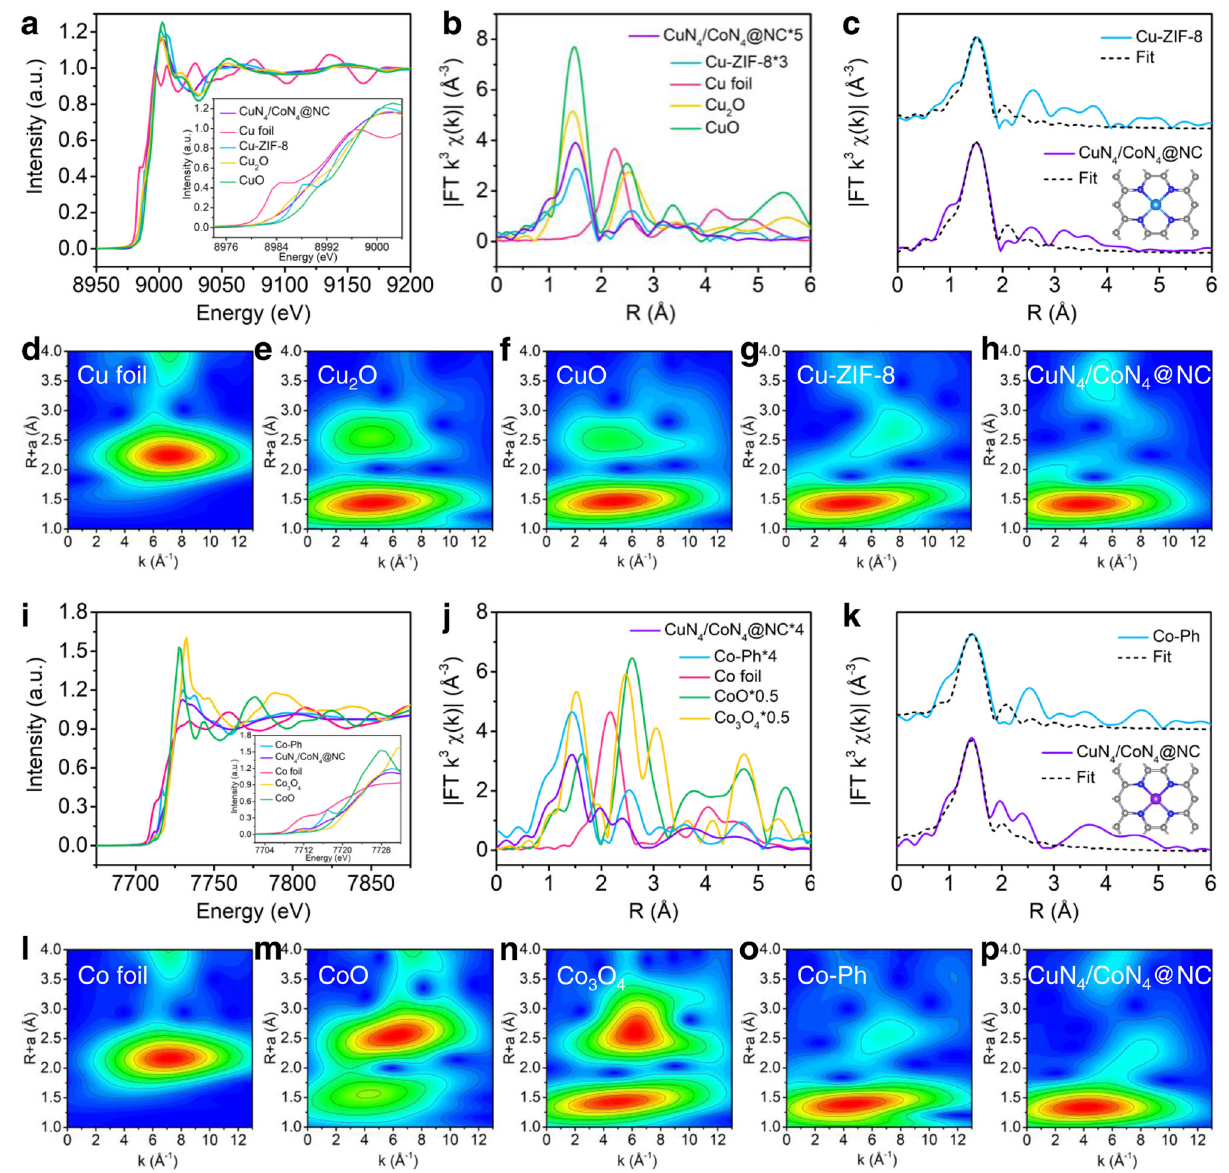
Fig. 2 | Atomic structural analysis of CuN 4 /CoN 4 @NC. a Cu K-edge XANES spectra, b Fourier-transformed (FT) k 3 -weighted EXAFS spectra for the Cu K-edge, c CuK-edgeEXAFS fi ttingcurvesofCuN 4 /CoN 4 @NCandCu-ZIF-8inRspace(inset: model of CuN 4 sites), d – h Wavelet-transformed k 3 -weighted EXAFS spectra. i